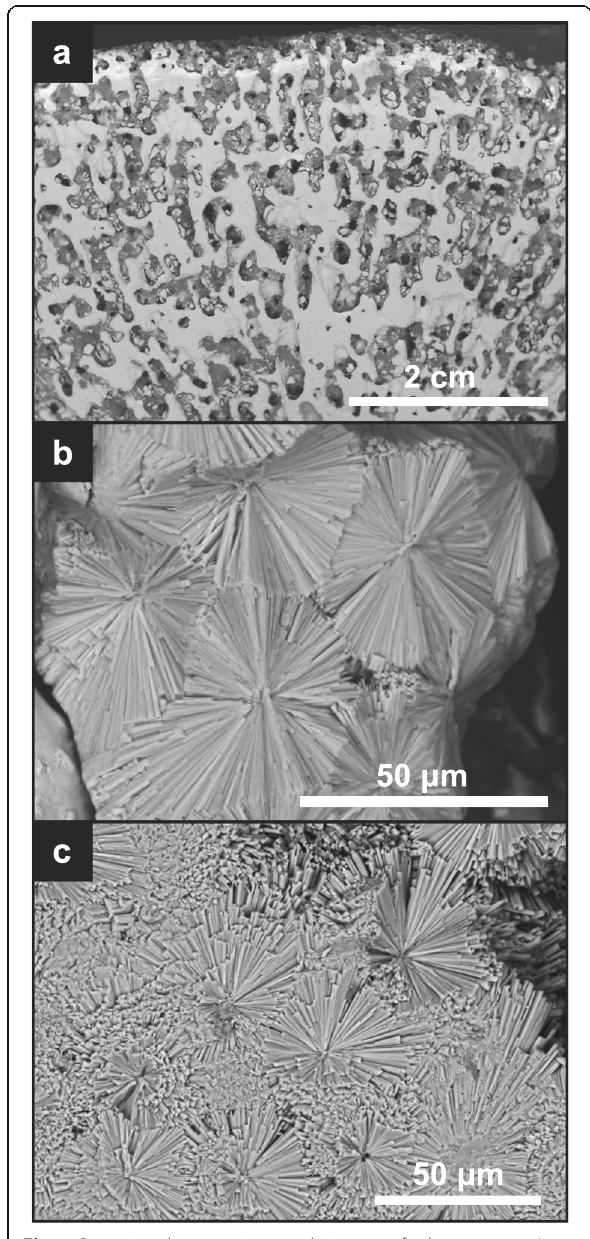
Fig. 5 Scanning electron micrograph images of sclerosponges. A well-preserved pristine aragonite skeleton is visible ( a , b KMJ-38-14; c